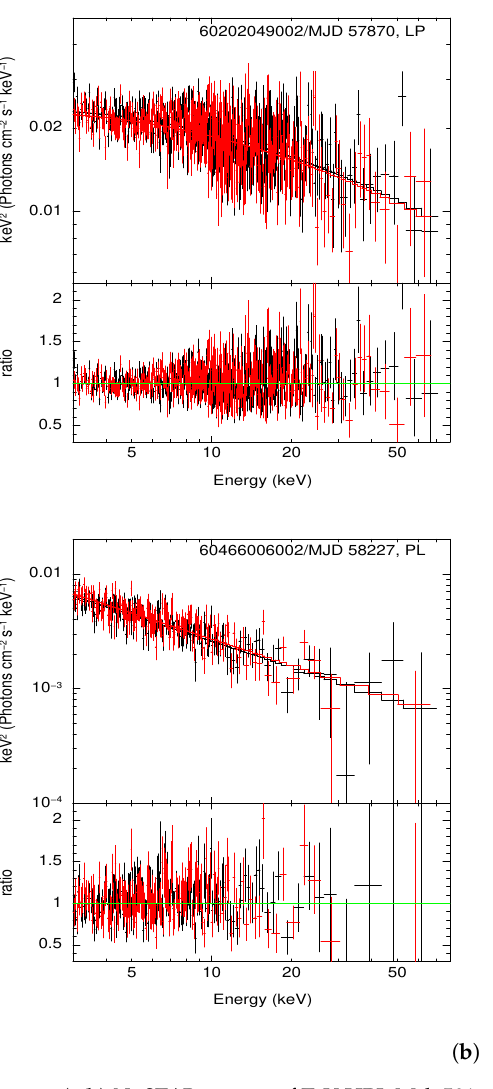
Figure 3. ( a , b ) NuSTAR spectra of TeV HBL Mrk 501 with the best fitting model in the upper panel and the ratio (data/model) in the bottom panel of each plot. The observation ID, MJD of observation, and the best fitting model are given in each